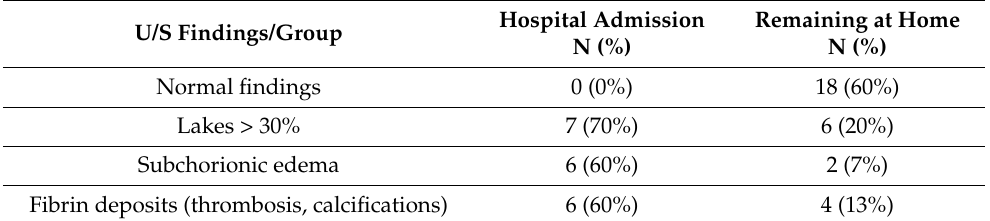
Table 2. Number of cases with placental ultrasonographical findings in each group.